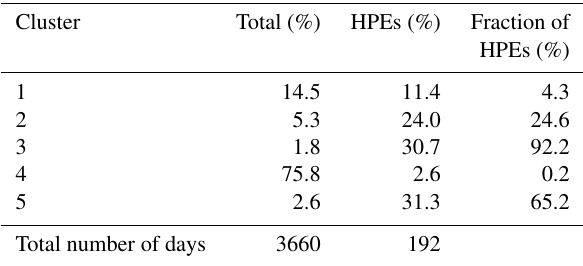
Table 2. Classification of days computed from 24h rainfall amounts in southern France (1981–2010), percentage of HPEs, and fraction of HPEs. HPEs (%) refers to the ratio between the number of HPEs within the cluster and the total number of HPEs. Fraction of HPEs (%) refers to the ratio between the number of HPEs within the clus- ter and the total number of dates included in the corresponding clus-